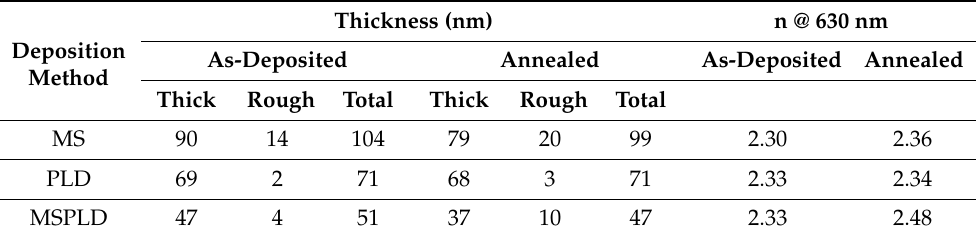
Table 5. ZnS films thicknesses and refractive indices determined by spectroscopic ellipsometry analysis. The layer thickness (Thick), layer roughness (Rough), and the total film thickness (Total) are